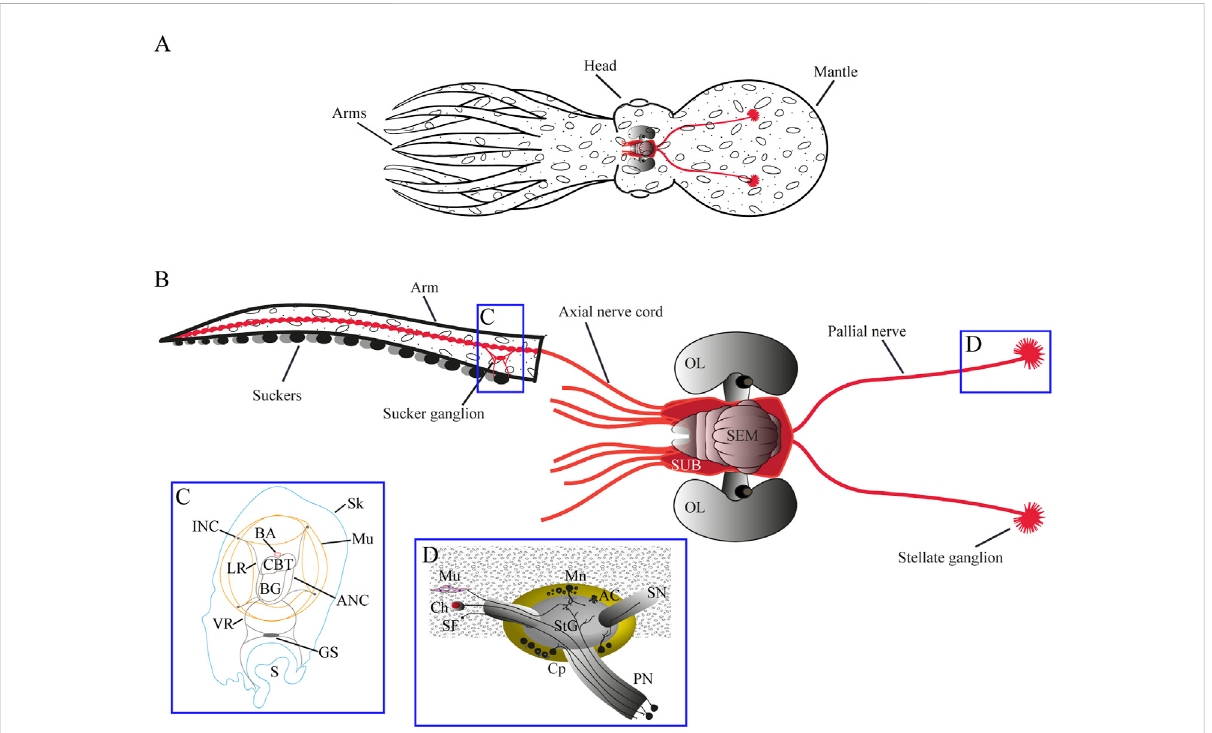
FIGURE 2 (A) Schematicdrawingof Octopusvulgaris morphology.Generalanatomyisshownin (A) while (B) showsmainstructuresofthenervoussystem withthebrain(CNS)locatedintheheadoftheoctopus,twopallialnervesarising(inred)fromitsposteriorpartandeightnervecords(inred)fromthe anterior part innervating the arms. (C) highlights main structures in the arm (transverse section) and (D) highlights neural components of the pallial nerveandstellateganglion,togetherwithmainconnections.Particularly,pallialnervesareapairedneuralstructurecomposedof fi berscovered in connective tissue, whose cell soma are mainly located in the subesophageal mass of the brain. Some of these fi bers make synapsis (D) in the stellate ganglion for the control of the breathing muscles, while other axons travel directly to the skin to innervate chromatophores in the mantle (Young, 1971;BudelmannandYoung, 1985). Whilecompletetransectionof bothnerves leads to animaldeath due to paralysis of respiratory muscles (Fredericq, 1878), the lesion of just one of them is easily managed by the animals, even though camou fl age and breathing are impaired on the ipsilateral side of the injury (Fredericq, 1878; Sereni, 1929b; Imperadore et al., 2017). AC Amacrine cells, ANC axial nerve cord, BA brachial artery, BG brachial ganglion, Ch chromatophores, CBT cerebro-brachial tracts, CL cellular layer, CNS central nervous system, Cp centripetal cell, GS ganglion of sucker, INC. intramuscular nerve cords, LR lateral roots, Mn motoneurons, Mu muscular tissue, Nb neurobiotin, Np neuropil, OL optic lobe, PN pallial nerve, S sucker, SEM supra-esophageal mass, SF sensory fi bers, Sk skin, SN stellar nerve, StG stellate ganglion, SUB sub-esophageal mass, v blood vessels, VR ventral roots. Adapted by permission from Springer Nature: Springer -Verlag GmbH Germany, Invertebrate Neuroscience: Neural pathways in the pallial nerve and arm nerve cord revealed by neurobiotin back fi lling in the cephalopod mollusk Octopus vulgaris , Imperadore et al., Copyright ©